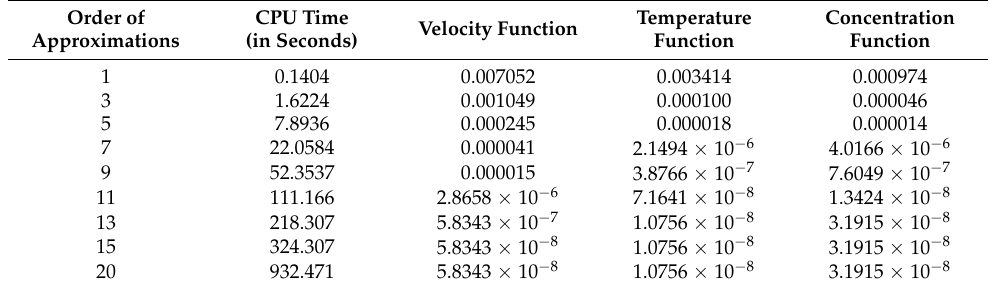
Table 2. Squared residual errors using a different order of approximations when β = 0.1, M = 0.2, Da = 0.5, Rd = 0.3,Pr = 1.0, Ec = 0.1, S = 0.1, Nb = 2.0, Nt = 0.5, Le = 1.0, and λ =